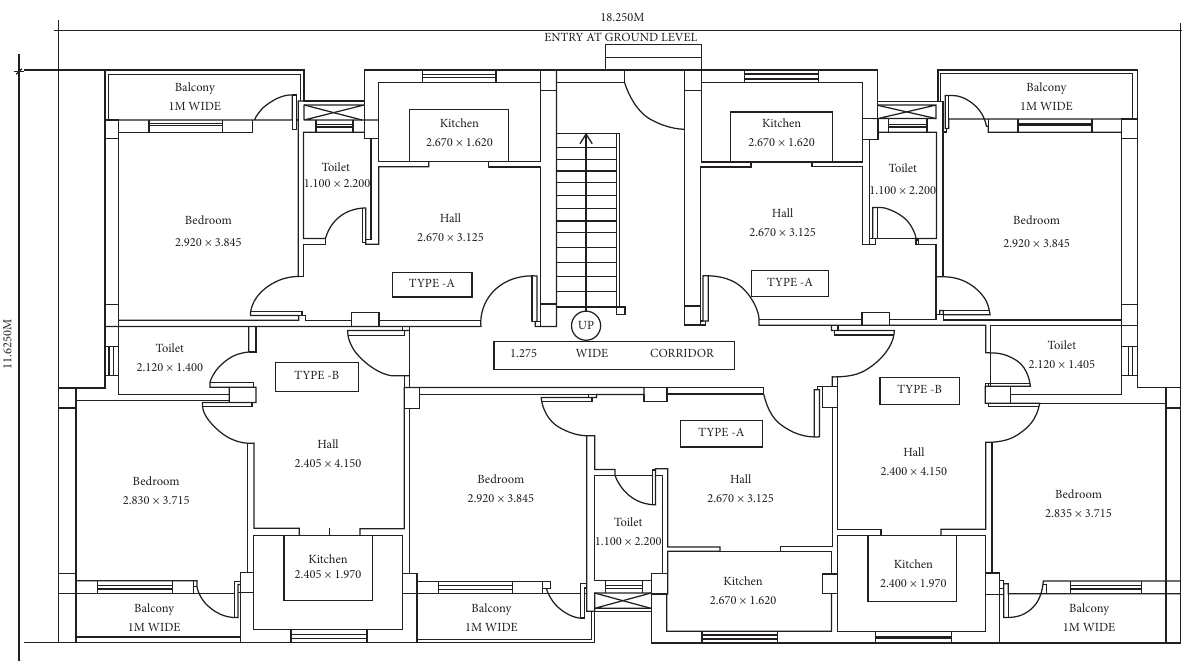
Figure 2: Typical architectural design of an IAHU